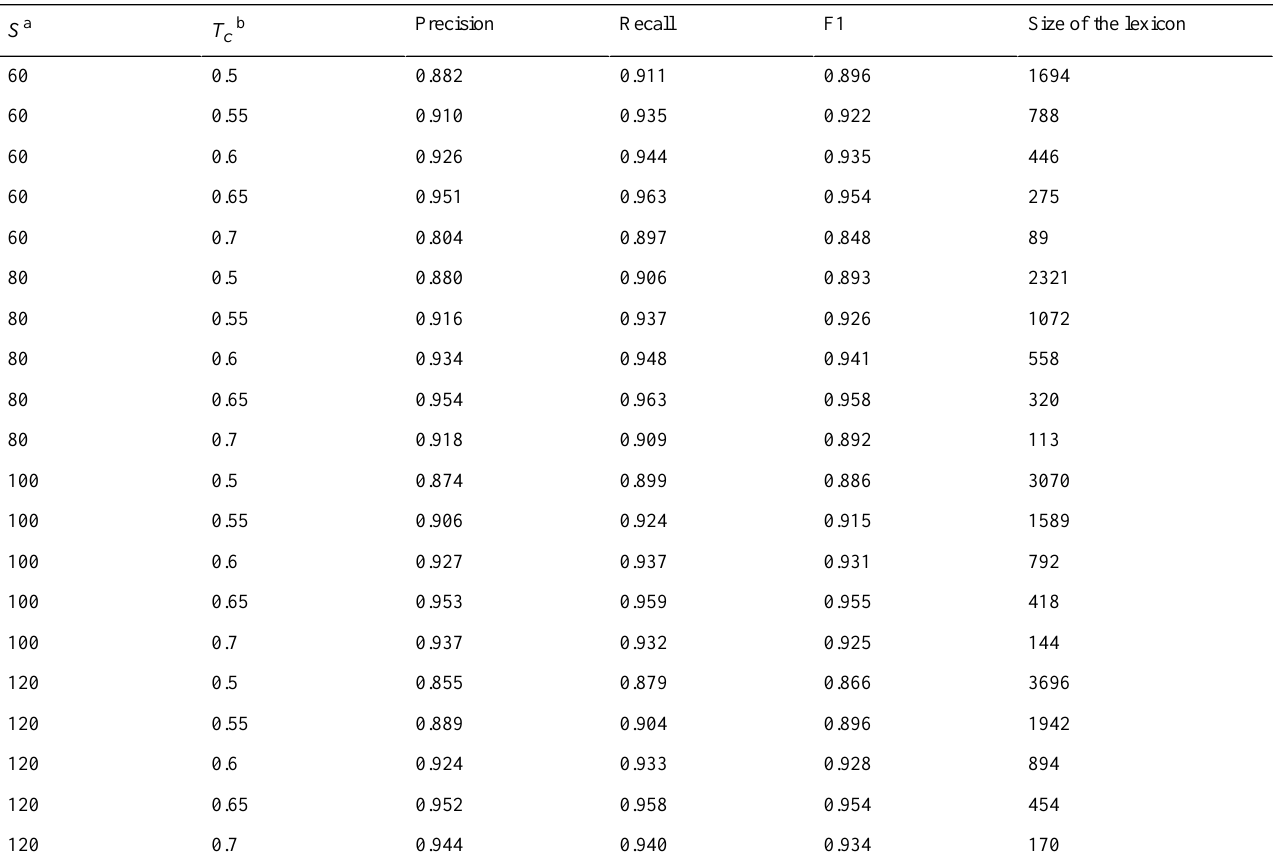
Table 5. Performance of the W2V-LPA method when S and T c were